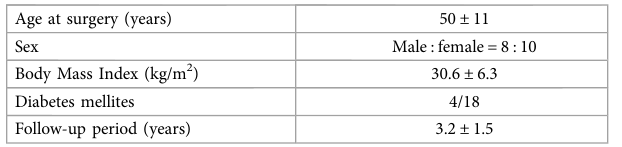
TABLE 1 Demographic data of the patients.